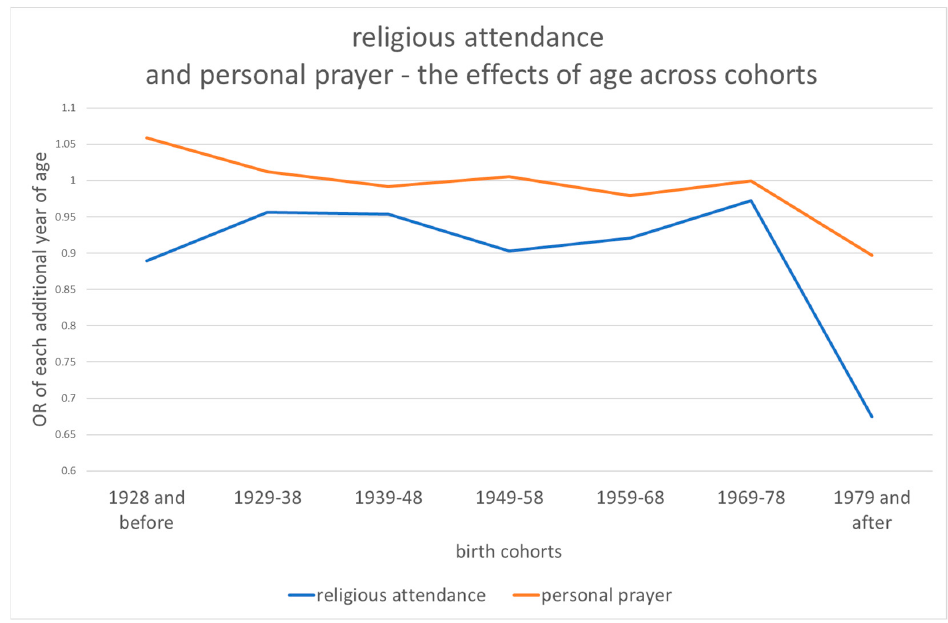
Figure 7. The effects of age across cohorts on religious attendance and personal prayer—odds ratios. Combined with the previous analysis, we deduce that religious attendance by men and Protestants is generally lower than that of women and Catholics, and that it also tends to decrease slightly less over time in these same sub ‐ groups. The wealthiest people practice less, but their practice also decreases faster with age than other income